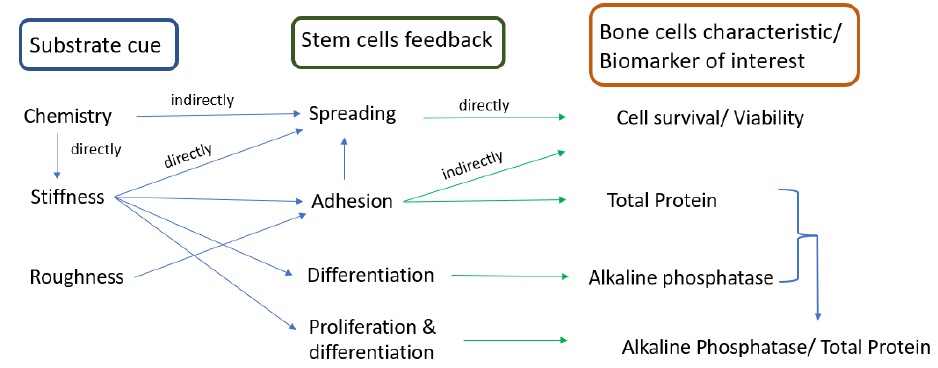
Figure 1. Correlation between substrate characteristics, stem cells feedback, and the corresponding biomarker.